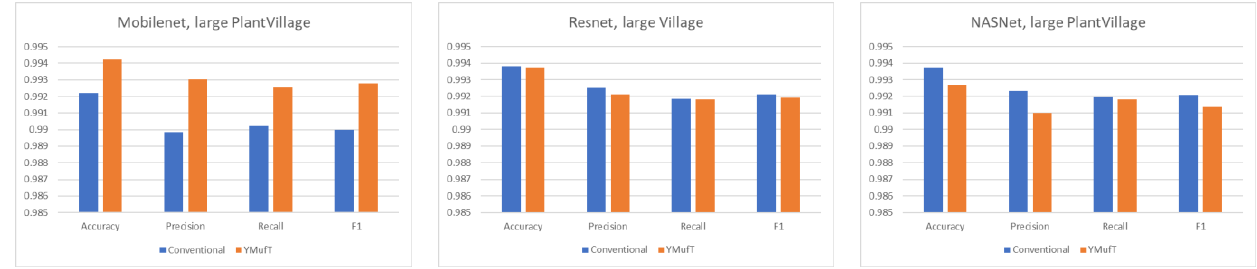
Figure 15. Overall performance on the large PlantVillage test set.